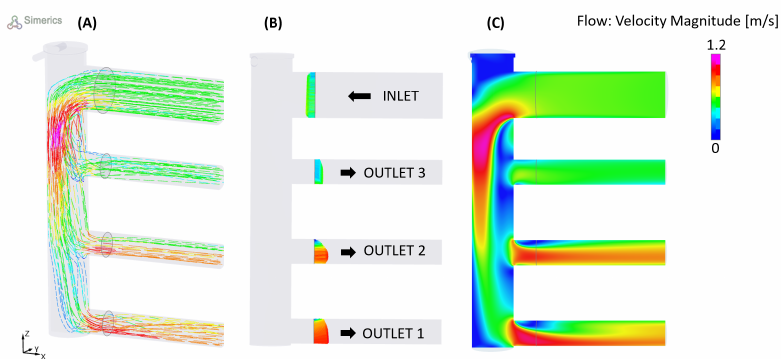
Figure 6. The 3D CFD simulation of flow rate distribution in the manifold. ( A ) Streamlines view; ( B ) vectors view; ( C ) contour view.